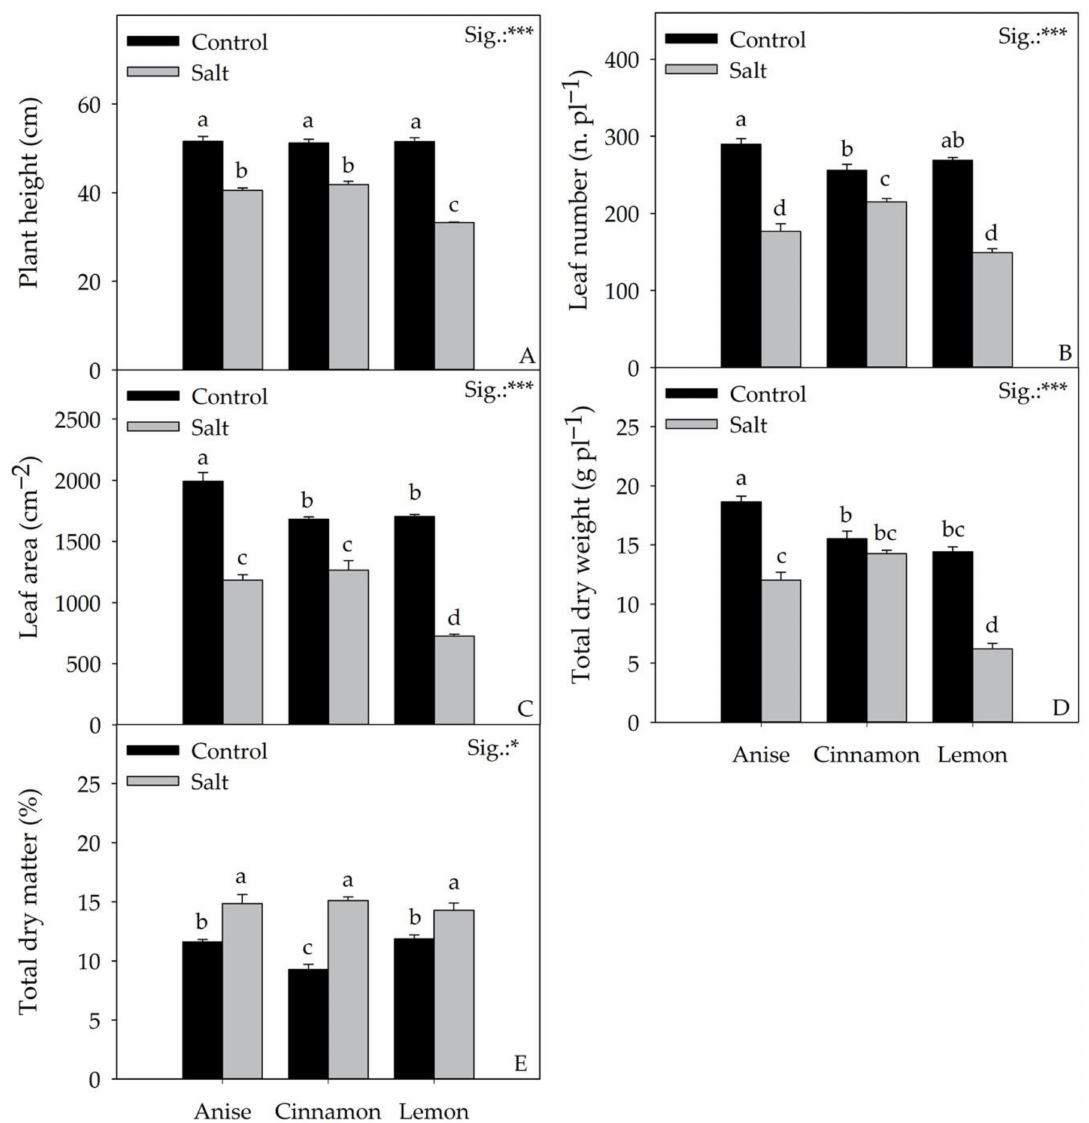
Figure 3. Effect of Cultivar × Stress on plant height ( A ), leaf number ( B ), leaf area ( C ), total dry weight ( D ), total dry matter ( E ). Data are mean values ± standard error, n = 3. Statistical significance of the CV × S interaction was determined by Tukey HSD test for Cultivar and by t -Test for Stress. Different letters indicate significant mean differences. * and *** denote significant effects at p ≤ 0.05 and 0.001,